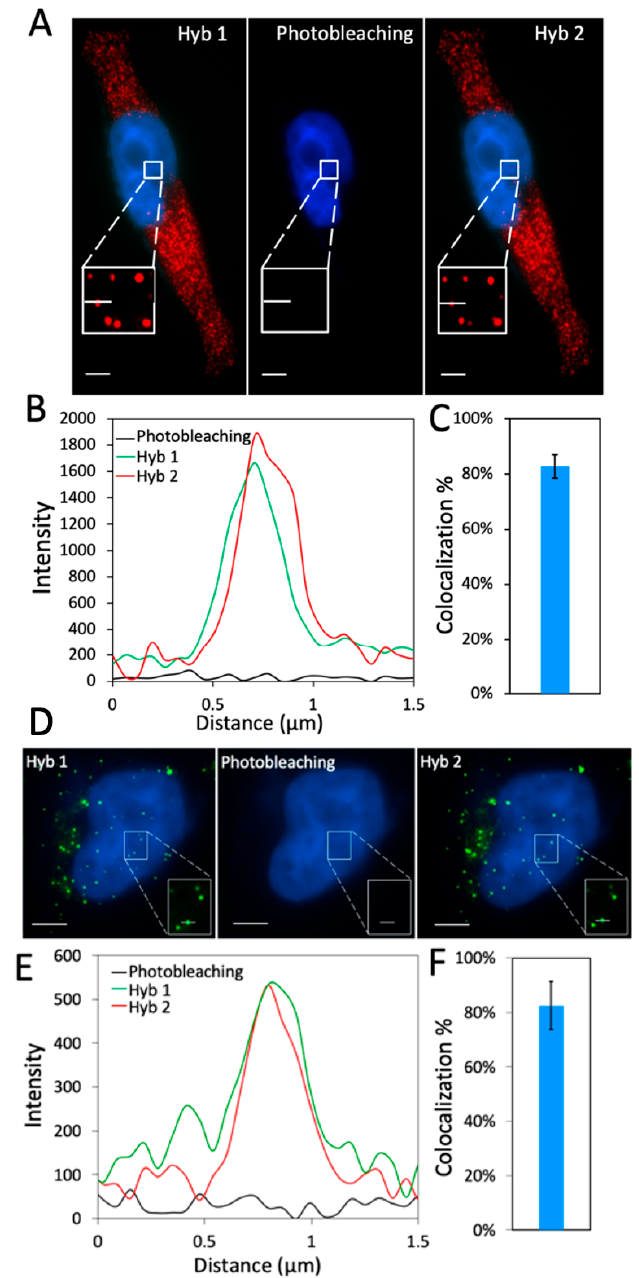
Figure 2. ( A ) GAPDH transcripts in HeLa cells are detected with Cy5 labeled decoding probes in two cycles of C-FISH. ( B ) Signal intensity profiles corresponding to the line positions in (A). ( C ) Fraction of GAPDH spots identified in the first cycle of hybridization that reappeared in the second cycle ( n = 30 cells). ( D ) Ki67 transcripts in HeLa cells are detected with Quasar 570 labeled decoding probes in two cycles of C-FISH. ( E ) Signal intensity profiles corresponding to the line positions in (D). ( F ) Fraction of Ki67 spots identified in the first cycle of hybridization that reappeared in the second cycle ( n = 30 cells). Scale bars, 5 µm.